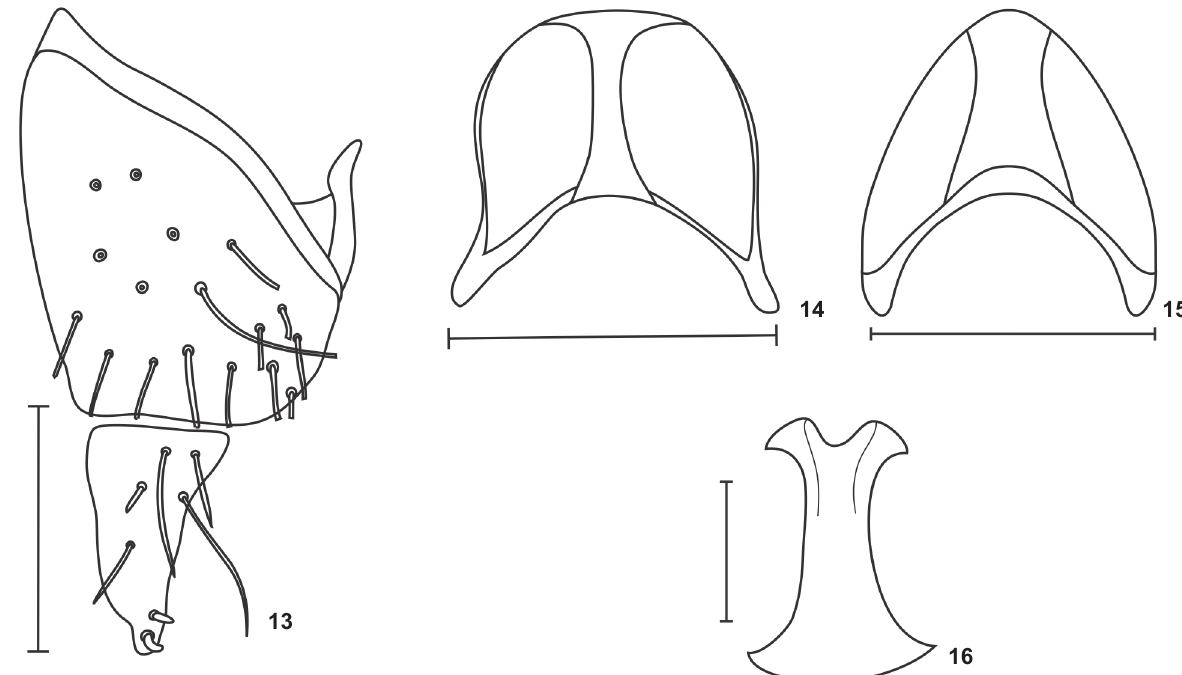
Figures 13-16. Male of L. flavopubescens : (13) gonocoxite and gonostylus; (14-15) ventral plate in two different dorsal views; (16) median sclerite. Bar: 0.1